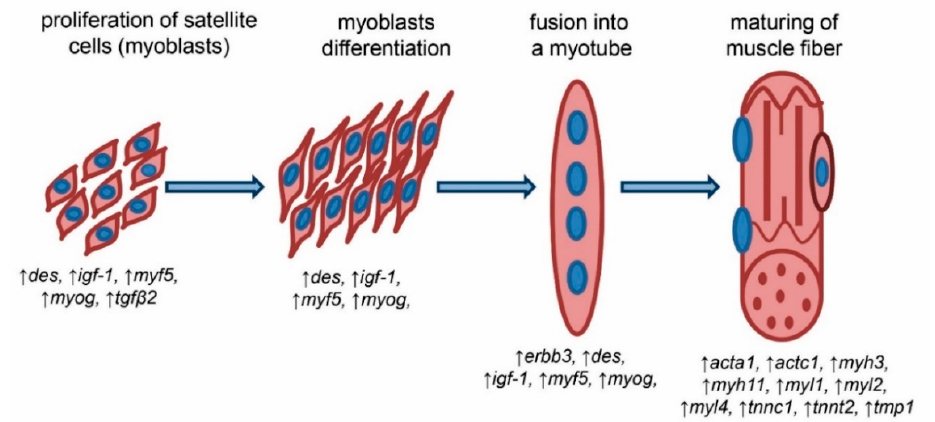
Figure 5. Involvement of the identified genes in processes associated with the development and maturation of muscle fibers.